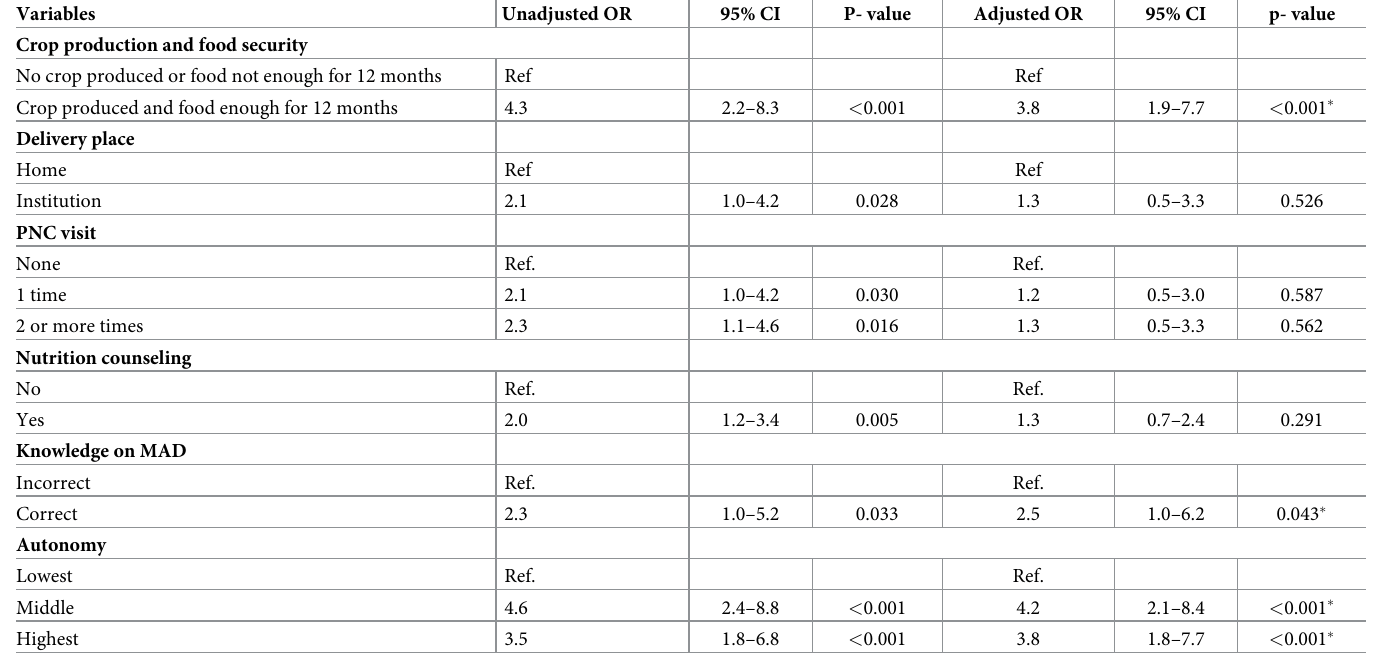
Table 7. Factors associated with minimum acceptable